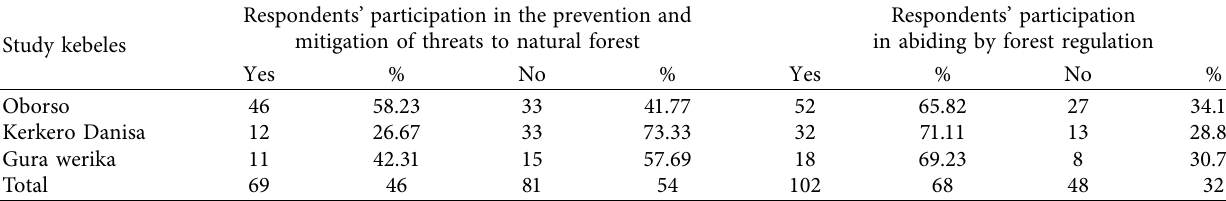
Table 7: Participation in protecting natural forest.